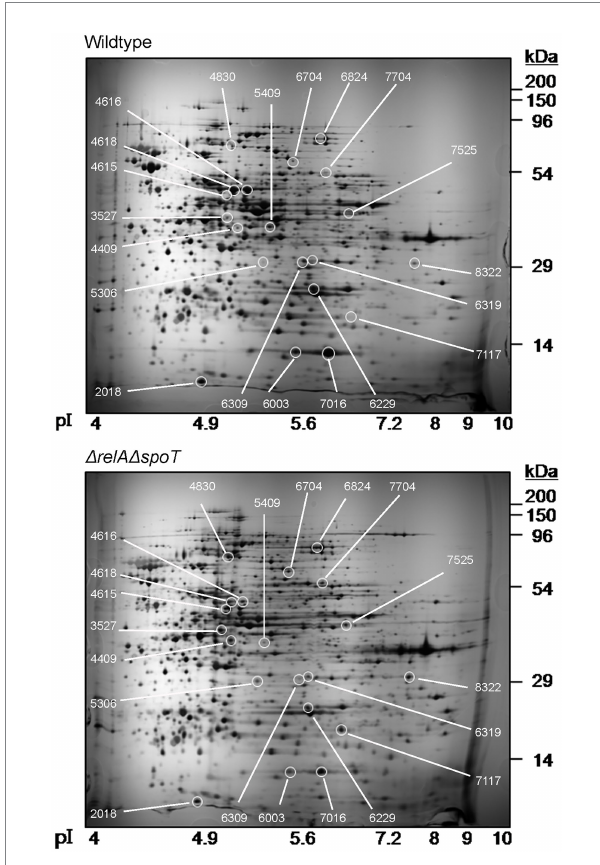
FIGURE 2 Two-dimensional proteomic analysis of wildtype and Δ relA Δ spoT mutant strains. Wildtype and mutant strains grown in Luria-Bertani (LB) at 37 ° C for 18 h were diluted in pre-warmed LB and further incubated at 37 ° C. Equal amounts (200 μ g) of proteins were obtained from each strain and subjected to two-dimensional proteomic analysis. Top, wildtype, E2348/69 strain; bottom, Δ relA Δ spoT , E2348/69 Δ relA Δ spoT